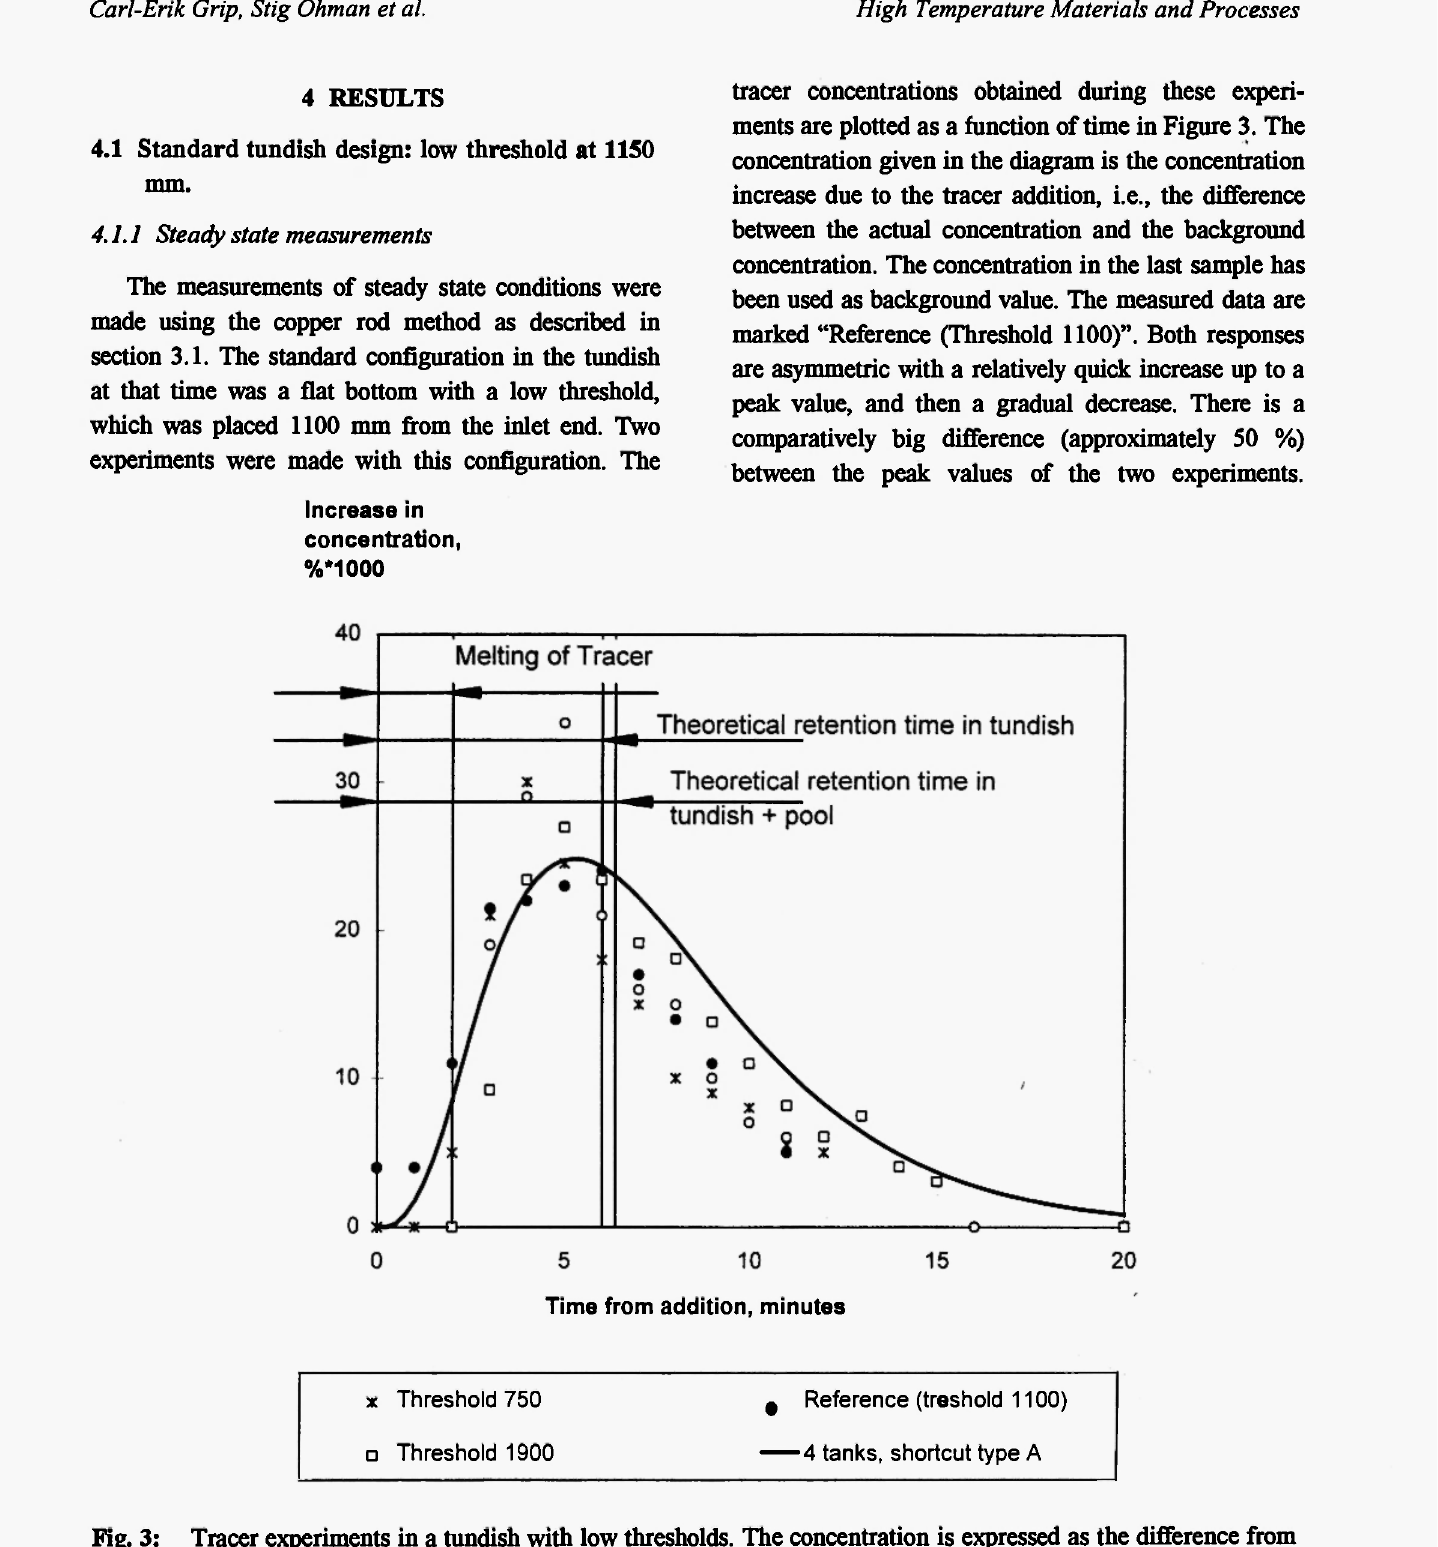
Tracer experiments in a tundish with low thresholds. The concentration is expressed as the difference from the background concentration. The observed melting time of the tracer is included for comparison as well as the theoretical retention time in tundish and pool. The experiments with the threshold in position 1100 are referred to as "Reference" in the other figures. A concentration curve calculated by the tanks in series model has been included in the diagram. The shortcut model, type A, is defined in table